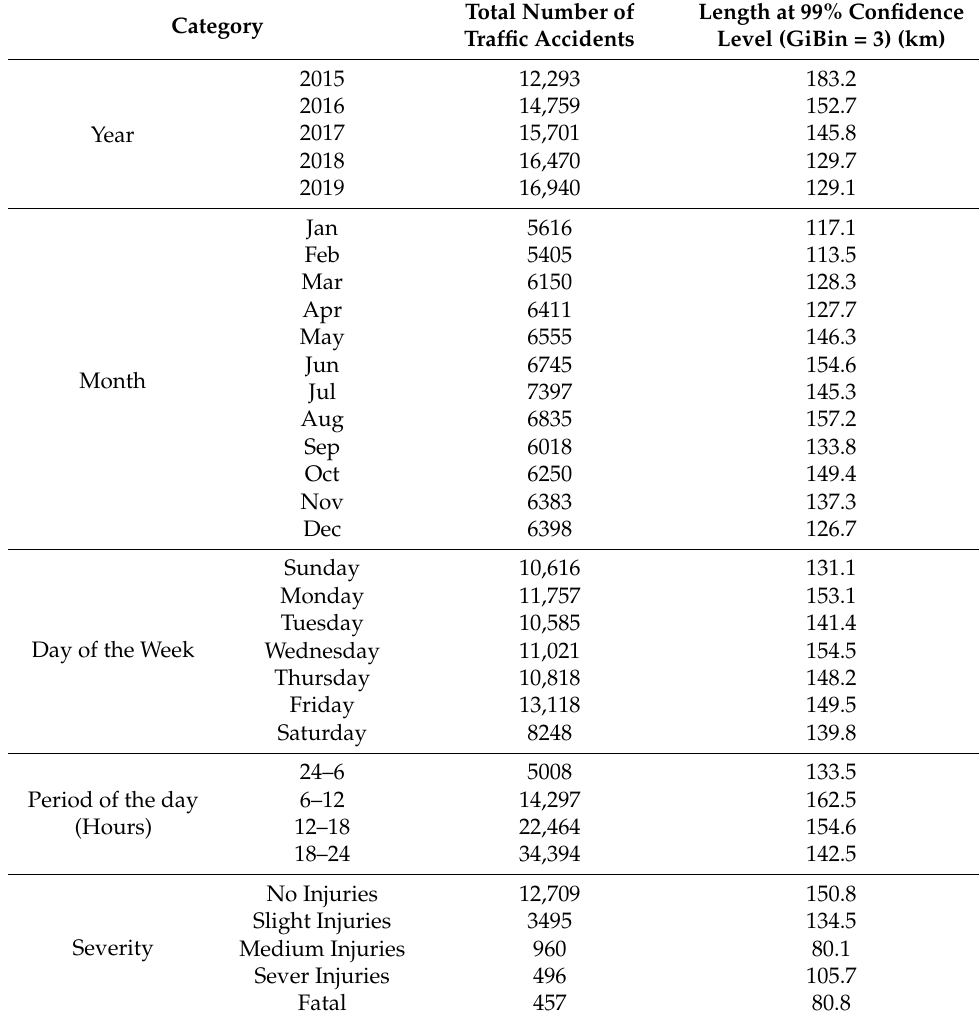
Table 4. Summary of hotspot statistics for each year, month, daily, period of the day, and severity level, and their associated road segments length at 99% confidence level (i.e., GiBin = 3) for traffic accidents in the Irbid Governorate. Total Number of Length at 99% Confidence Category Traffic Accidents Level (GiBin = 3)